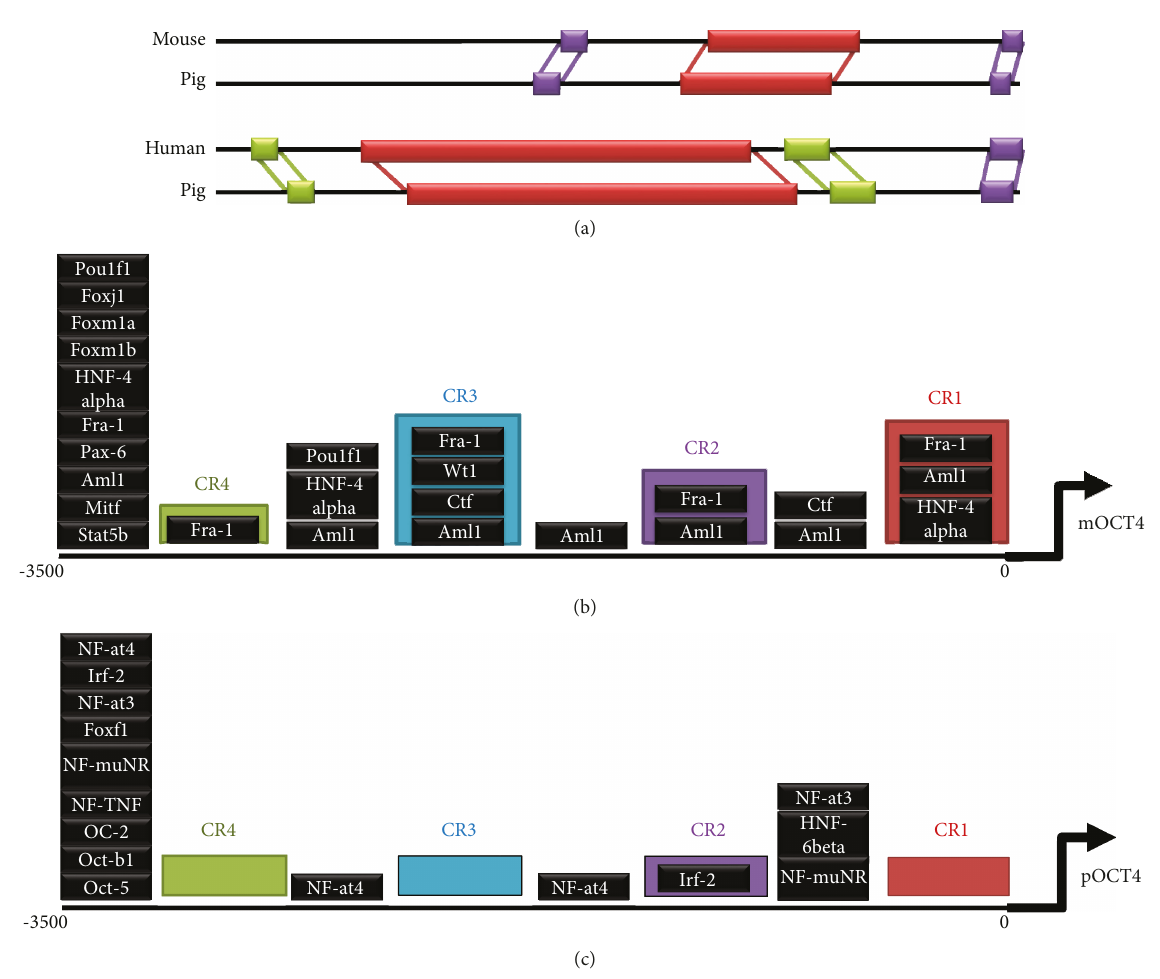
Figure 4: BlastN analysis and alignment of the putative transcription factor binding sites from mouse and pig using PROMO. (a) BlastN analysis between mouse and pig and human and pig. The color key for alignment scores: red: ≥ 200, purple: 80 – 200, and green: 50 – 80. (b) Putative transcription factor binding sites that exist in mouse sequences, but not in pig sequences. (c) Putative transcription factor binding sites that exist in pig sequences, but not in mouse